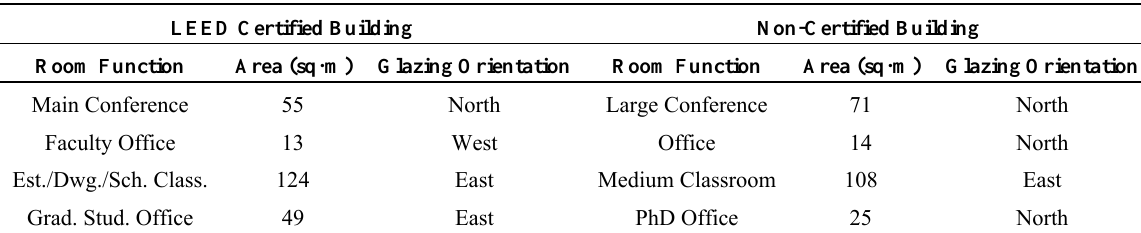
Figure 4. Energy use intensity (EUI) comparison by building and by building energy modeling (BEM) tool. Dashed line denotes the national median EUI for educational building types (328 kWh/sq·m). Table 2. Characteristics of the rooms used in daylighting